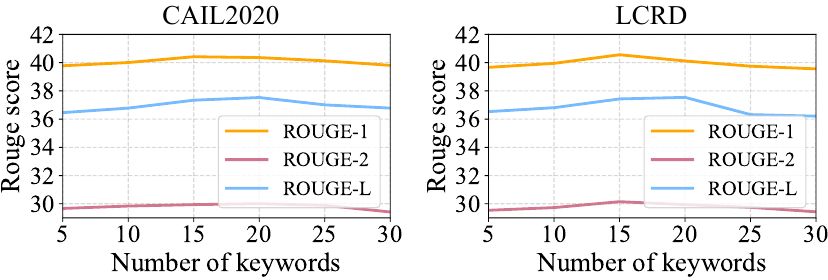
Figure 6. Experimental results for k sparse softmax.